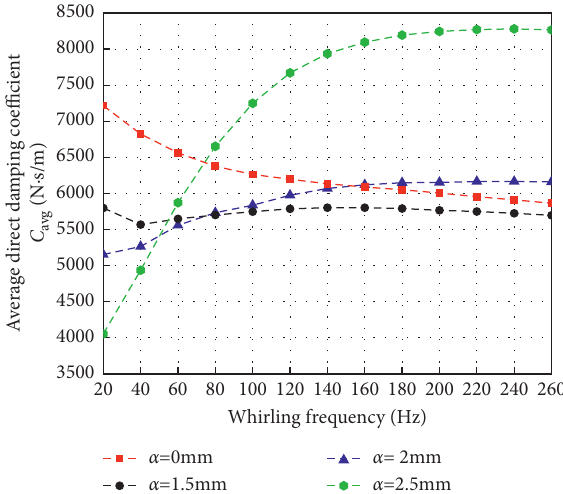
Figure 14: Average direct damping coefficient vs. whirling frequency.